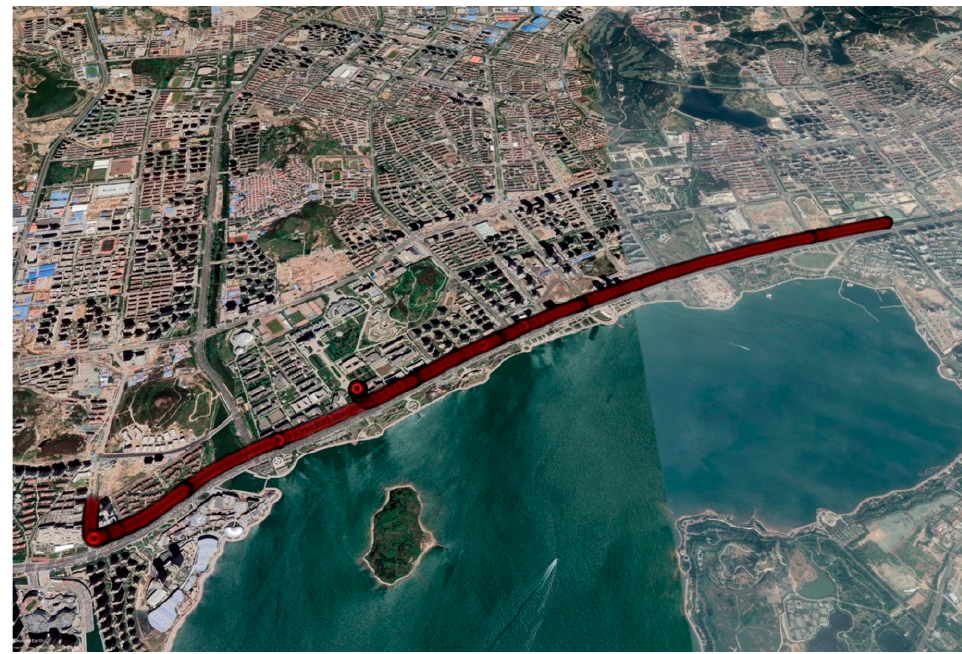
Figure 2. The trajectory of land vehicle in Experiment A.